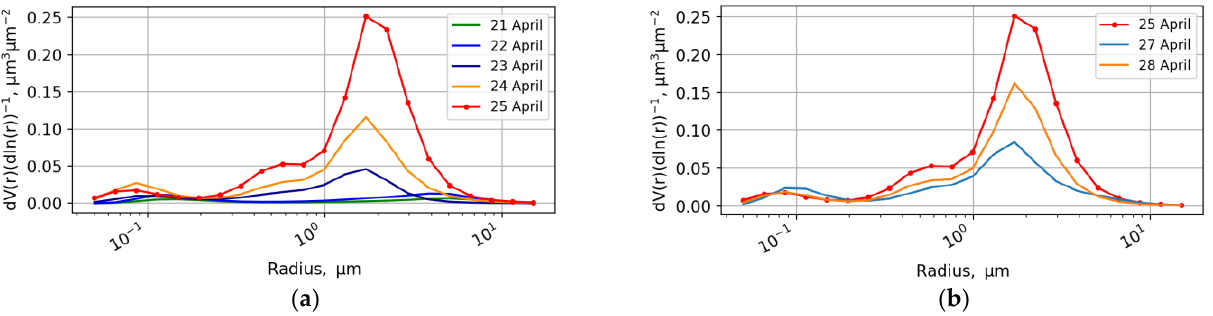
Figure 5. Aerosol volume size distribution on ( a ) 21 – 25 April and ( b ) 25 – 28 April 2019. Data level 2.0. Data on 26 April are not available.